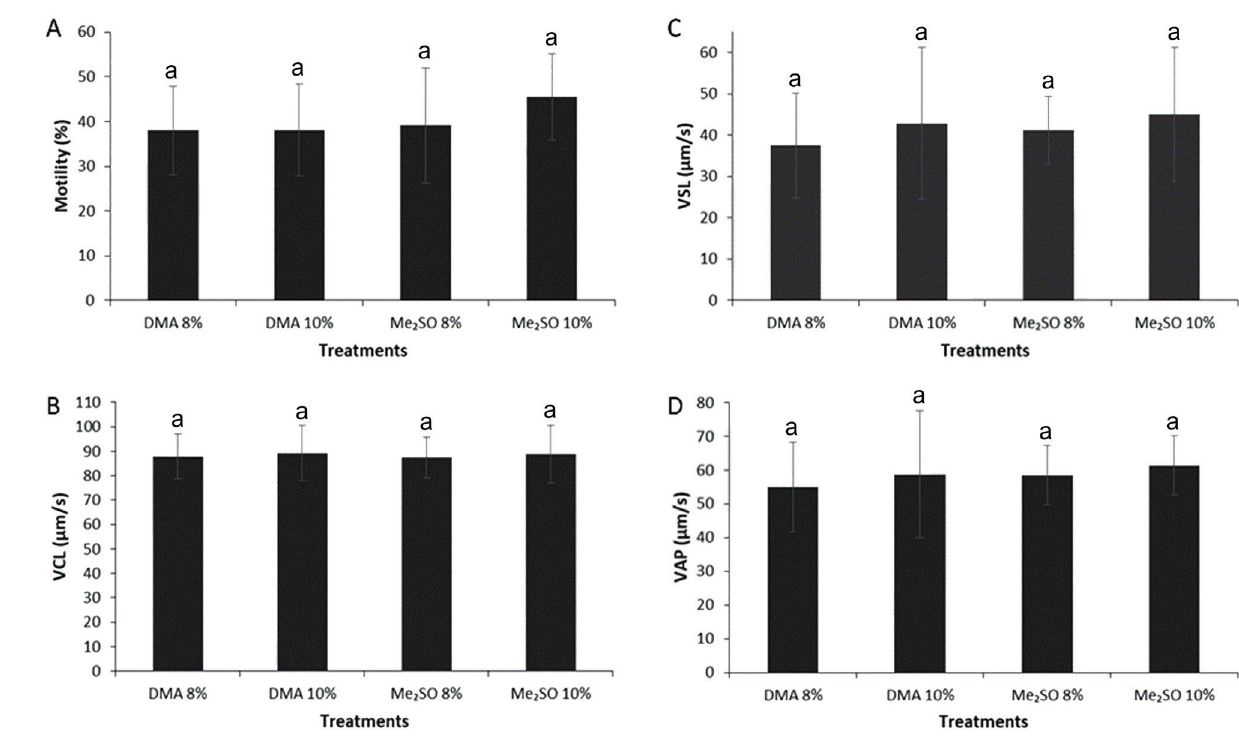
FIGURE 4 | Analysis of the sperm movement of thawed semen from Pseudoplatystoma corruscans. A. Total motility (MT), B. Curvilinear velocity (VCL, µm/s), C. Straight line velocity (VSL, µm/s), D. Average path velocity (VAP, µm/s). Same letters indicate no significant differences (P <